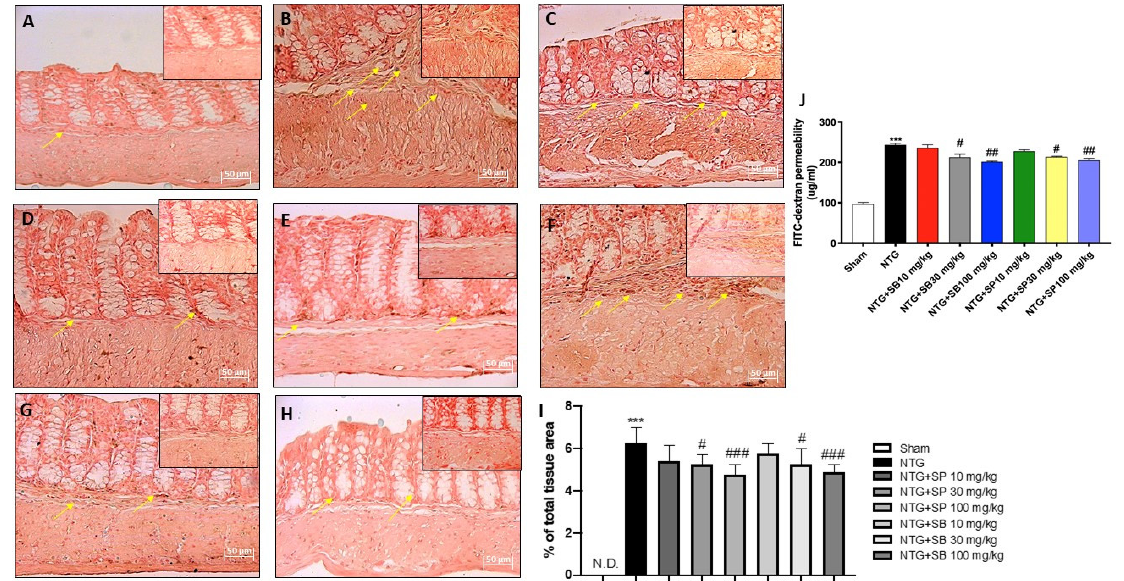
Figure 7. SCFAs treatment re-establishes intestinal permeability. Immunohistochemical localization revealed that NTG group ( B ) was characterized by high expression of E-cadherin compared to sham group ( A ) however, SCFA treatment ( D , E , G , H ) significantly decreased E-cadherin expression. No significant difference was revealed in mice treated with 10 mg/kg of SCFAs ( C , F ). The yellow arrows indicated positive cells. N.D. = not detected. FITC–Dextran assay revealed that SCFAs treatment significantly inhibited the increase in intestinal permeability ( J ). ( I ) *** p < 0.001 vs. sham; # p < 0.05 vs. NTG; ### p < 0.001 vs. NTG. ( J ) *** p < 0.001 vs. sham; # p < 0.05 vs. NTG; ## p < 0.01 vs.